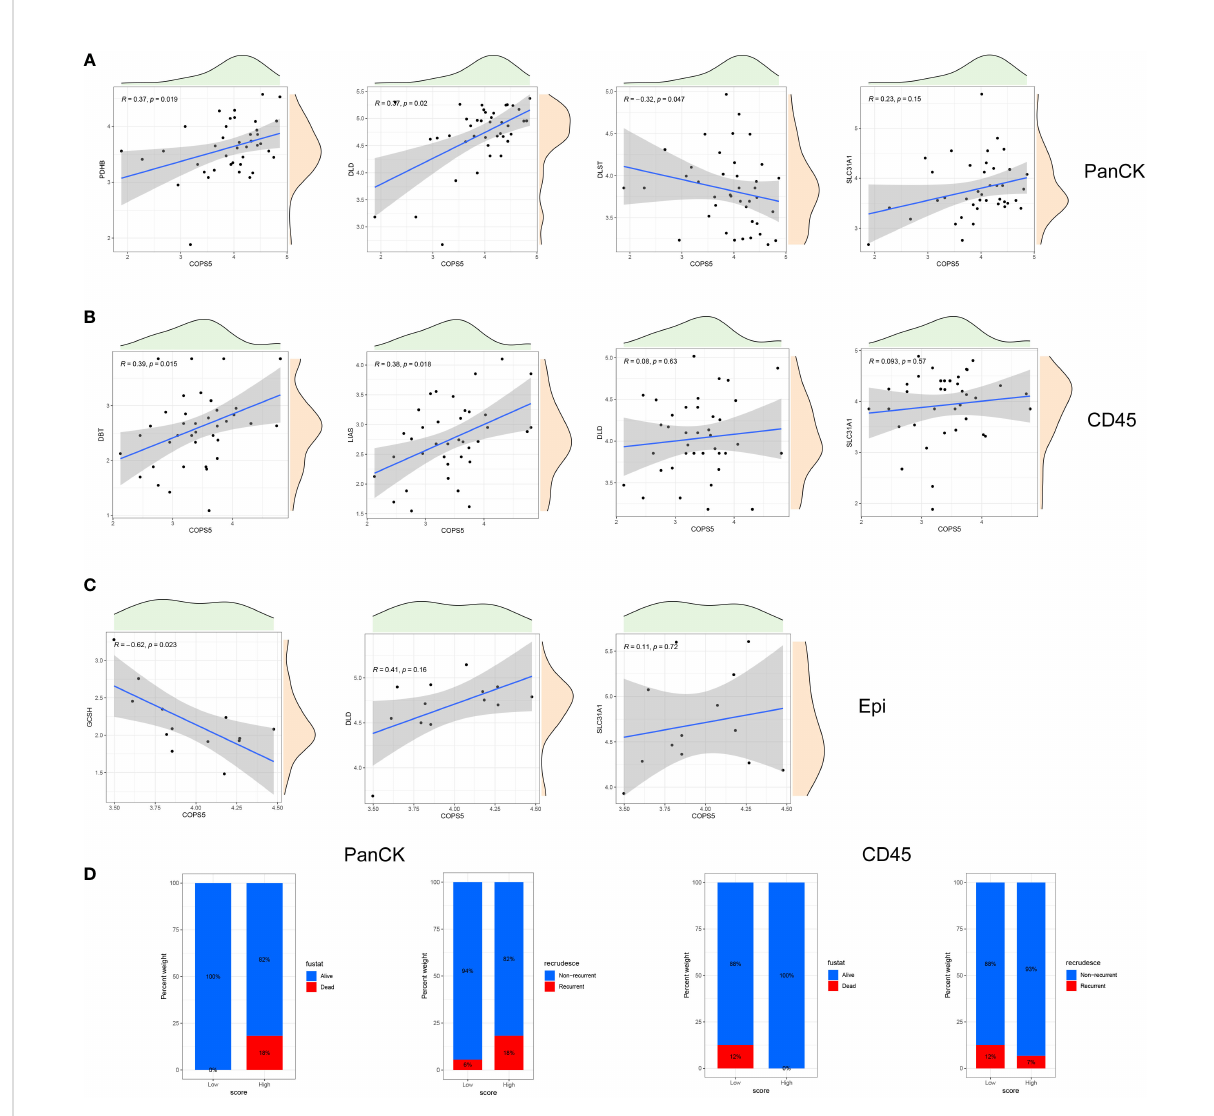
FIGURE 4 Correlation of cuproptosis related genes and Jab1 in different regions. (A) A correlation scatter plot: Jab1 correlates with the expression of cuproptosis related genes in tumor cell-enriched region. (B) A correlation scatter plot: Jab1 correlates with the expression of cuproptosis related genes in immune cell-enriched region. (C) A correlation scatter plot: Jab1 correlates with the expression of cuproptosis related genes in normal epithelial region. (D) NPC patient status distribution (PCA group) in tumor cell-enriched region and immune cell-enriched